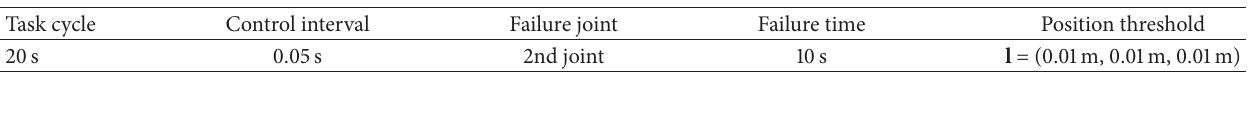
Table 3: Analysis of velocity jump and acceleration with compensation for each joint.